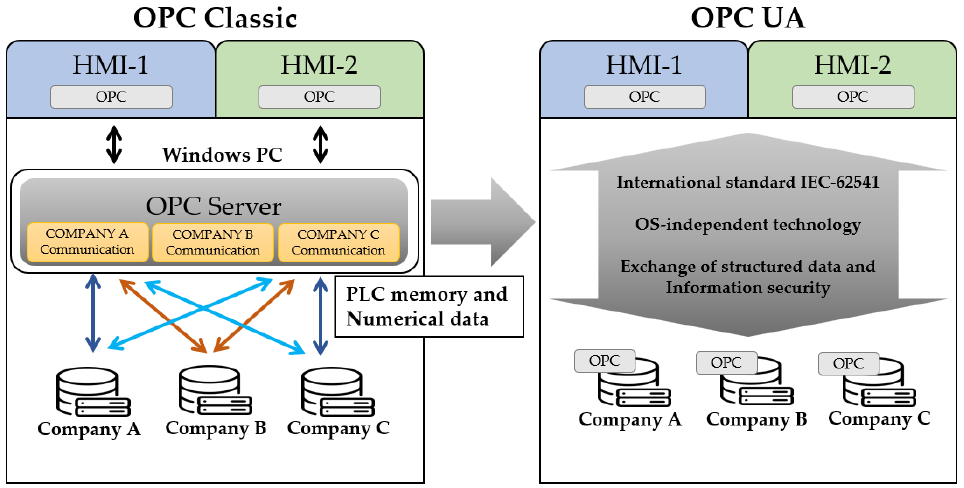
Figure 3. Comparison between OPC Classic and OPC UA.